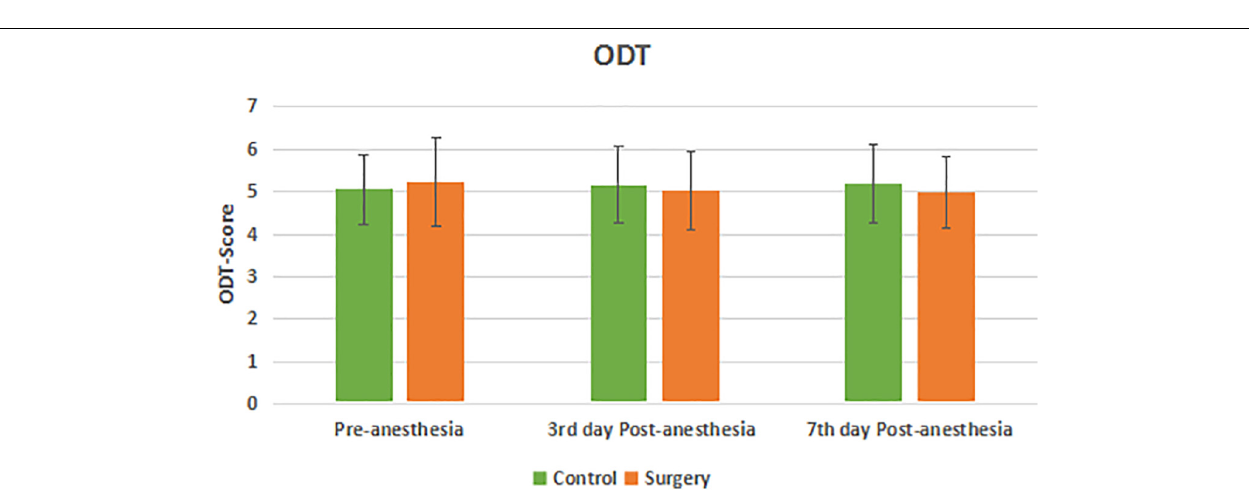
FIGURE 2 | Olfaction detection threshold between the two groups. There was no significant decrease in ODT score at 3rd and 7th day Post-anesthesia in the surgical group compared with pre-anesthesia. There was no significant difference in ODT score in the surgical group compared with the control group.